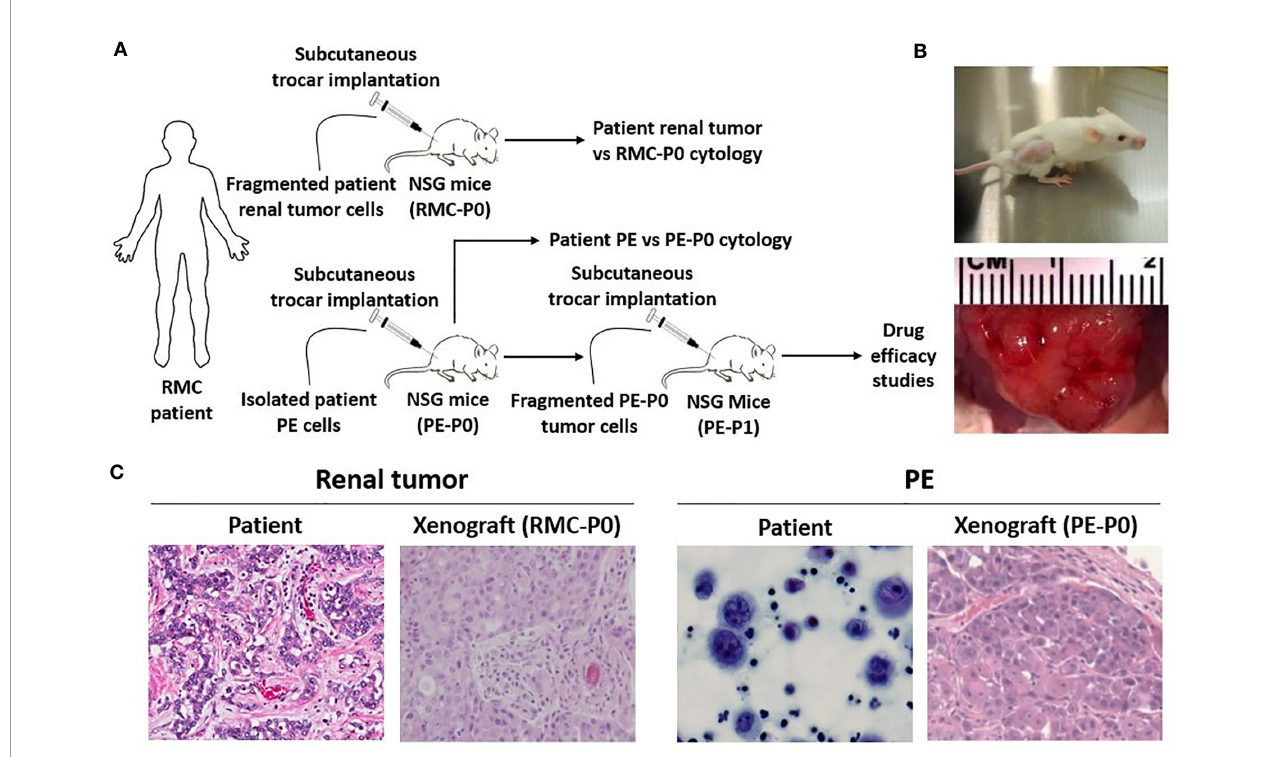
FIGURE 2 | RMC patient-derived xenograft models are created using NSG mice. (A) Experimental scheme for subcutaneous transplantation of patient renal tumor and PE cells into the fl ank of NSG mice. Fragmented PE tumor cells from the P0 group were serially transplanted into the P1 group for drug ef fi cacy studies once P0 tumor size reached 1000 mm 3 . (B) Tumor development in secondary mice. Tumor size can be seen in the fl ank of the mouse (top) and through gross observation of the tumor during necropsy (bottom). (C) Classic histopathologic features of RMC were noted in the patient renal tumor, including irregular glands and nests of epithelial cells in a vascular, desmoplastic stroma. These features were replicated in the xenograft. Both patient PE cytology and PE-derived xenograft pathology showed essentially undifferentiated malignant